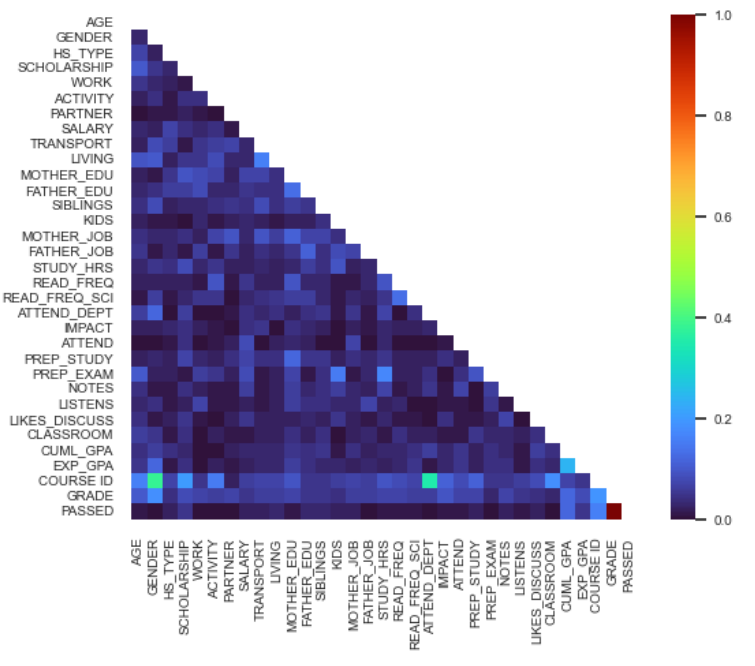
Figure 4. Cramer’s V matrix: offline.